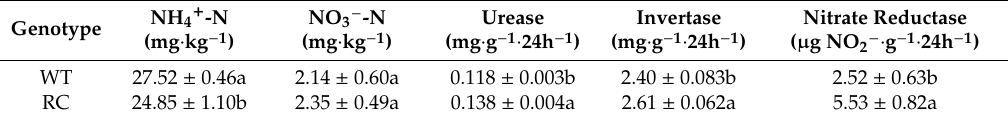
Table 5. N-related physicochemical properties of rice rhizosphere soil under no nitrogen treatment (LN).